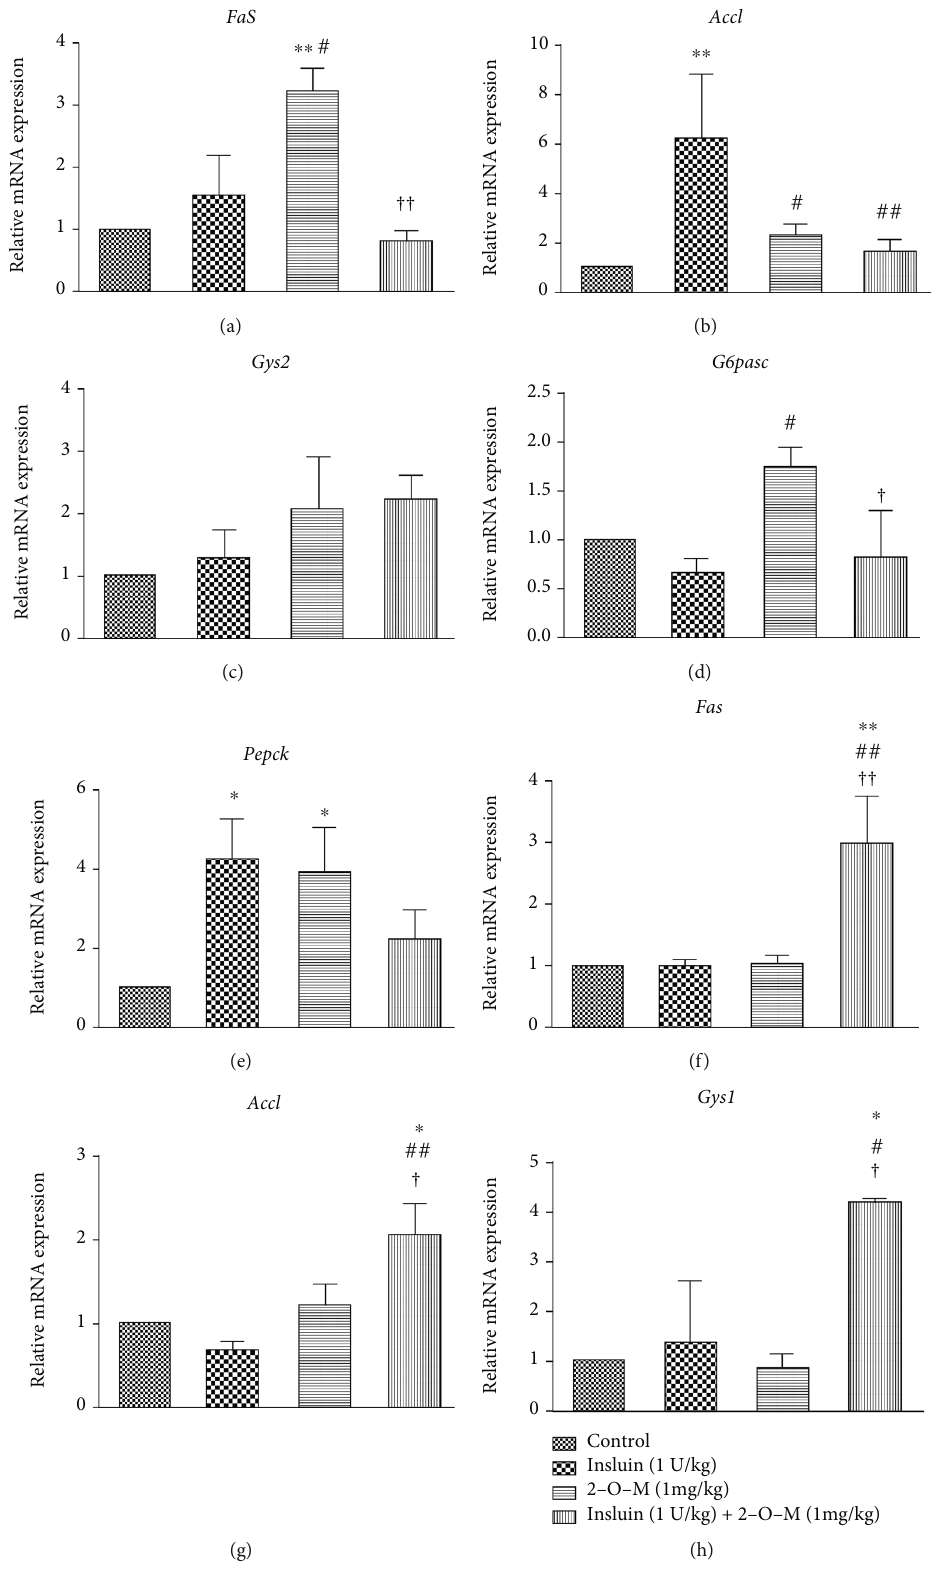
Figure 7: The e ff ect of 2 ′ -O-methylperlatolic acid (2-O-M) on glycogen synthesis, fat synthesis, and gluconeogenesis genes in db/db mice. (a – e) Genes in the liver. (f – h) Genes in the muscle. Data are shown as the mean ± SEM ( n = 6 in each group). ∗ p < 0 : 05 ; ∗∗ p < 0 : 01 versus control. # p < 0 : 05 ; ## p < 0 : 01 versus insulin. † p < 0 : 05 ; †† p < 0 : 01 , 2-O-M versus